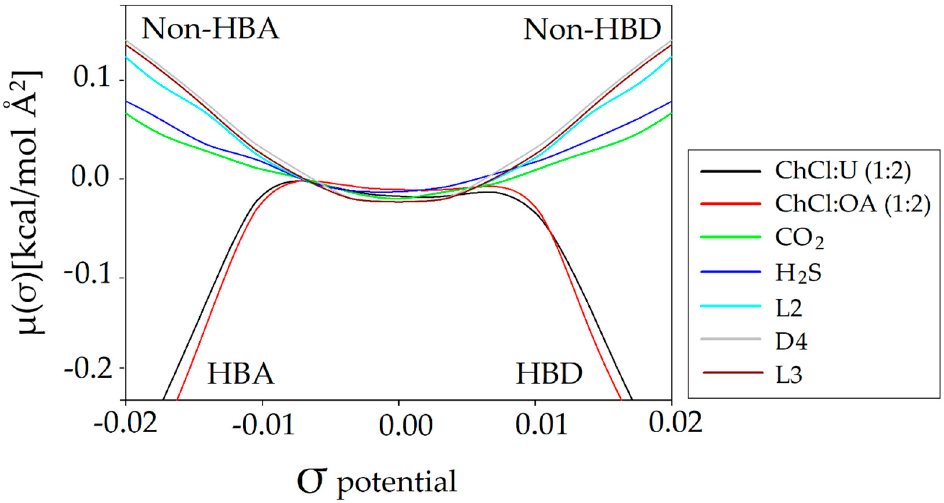
Figure 6. σ -potential of ChCl:U (1:2), ChCl:OA (1:2), CO 2 , H 2 S, L2, L3, and Figure 6. σ‐ potential of ChCl:U (1:2), ChCl:OA (1:2), CO 2 , H 2 S, L2, L3, and D4.